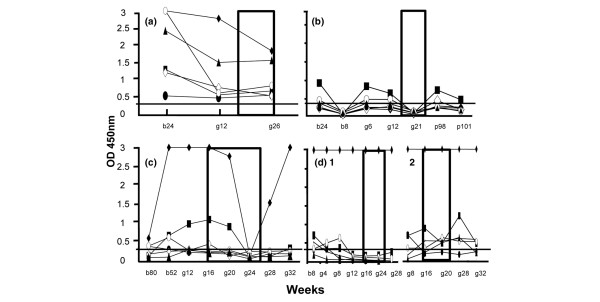
Longitudinal study of sera from lupus mothers of groups I and II with Ro antigens. The sera from lupus mothers of (a) group I and (b)–(d) group II were tested by ELISA before (b), during (g, for gestation) and after (p, for post) pregnancy. The number of weeks is indicated. Mother D had two consecutive pregnancies (D1 and D2). The rectangles represent the period known to be at risk (approximately weeks 16–26 of gestation), knowing that autoimmune-associated congenital heart block most often occurs between 18 and 24 weeks of gestation. Sera were tested at a 1:1,000 dilution. Only the IgG response was evaluated. All samples were systematically tested in at least two independent tests – the results shown in the figure correspond to one complete representative experiment. The sera were considered positive when the optical density (OD) values were ≥0.3 (horizontal lane). All sera were tested with the 48 antigens. Only the Ro antigens showing the highest reactivity are depicted in the figures; ◆, recombinant Ro52; ■, Ro52 peptide 1–13; •, Ro52 peptide 107–122; ◊, Ro52 peptide 277–292; ○, Ro52 peptide 365–382; ▴, La.